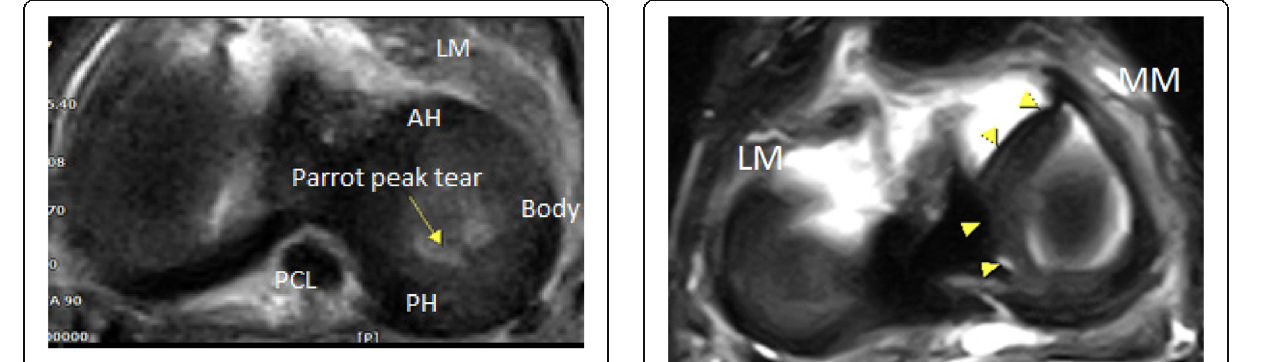
Fig. 5 Axial fat-saturated PD WI revealed small parrot peak tear (arrow) related to the free meniscal edge at the junction between the body and posterior horn. LM = lateral meniscus, AH = anterior horn, PH = posterior horn, and PCL = posterior cruciate ligament